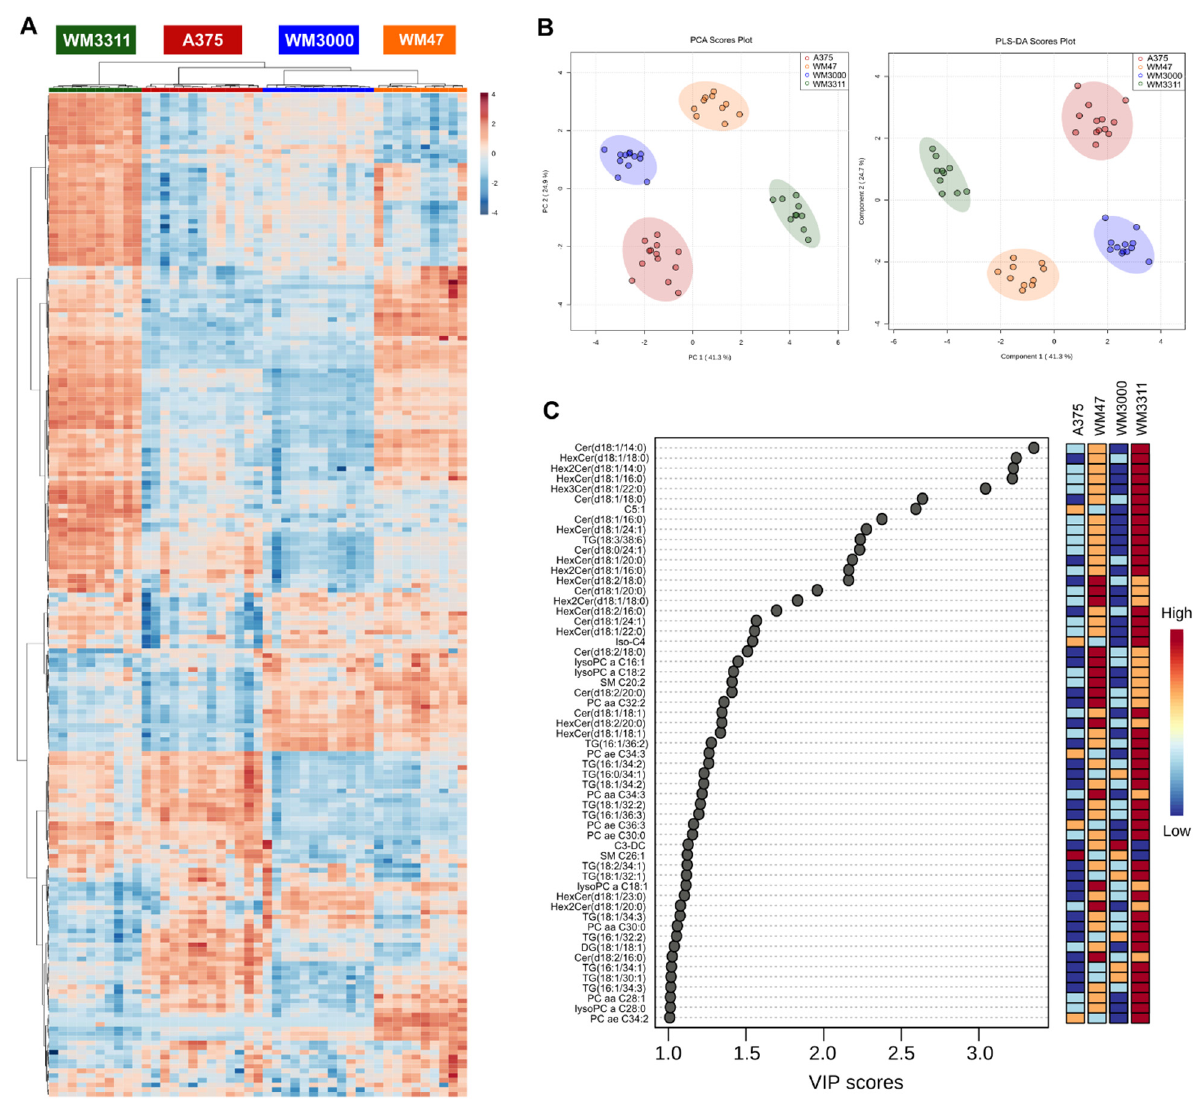
Figure 3. Metabolic analysis of lipids and lipid-like metabolites in melanoma xenografts. ( A ) Heatmap, ( B ) PCA and PLS-DA scores, and ( C ) PLS-DA VIP score derived from the lipid and lipid-like metabolite profiling data of A375, WM47, WM3000, and WM3311 melanoma xenografts. n = 10–13; aa: acyl-acyl, ae: acyl-alkyl, Cx:y:x = number of carbons in the fatty acid side chain and y = number of double bonds in the fatty acid side chain, C3-DC: malonylcarnitine C5:1: tiglylcarnitine, Cer: ceramide, DG: diglyceride, HexCer: hexosylceramide, Hex2Cer: dihexosylceramide, Hex3Cer: trihexosylceramide, Iso-C4: iso-butyrylcarnitine, lysoPC: lyso-phosphatidylcholine, PC: phosphatidylcholine, SM: sphingomyelin, TG: triglyceride.